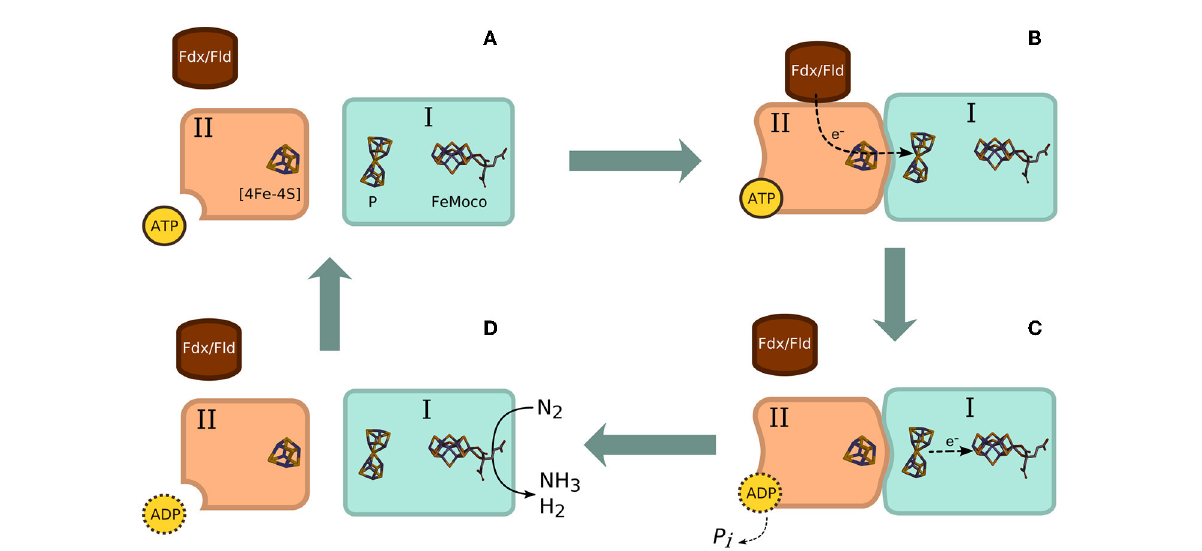
FIGURE4 Schematic presentation of nitrogen fixation via nitrogenase facilitation. (A) Detached nitrogenase components I ( dinitrogenase; MoFe protein ) and II ( dinitrogen reductase; Fe protein ) show II awaiting reduction by ATP. (B) ATP binds to component II initiating electron transfer from donor [Fdx ( ferredoxin ) or Fld ( flavodoxin )]. ATP binding triggers an allosteric structural change which leads to the components attaching. A flow of electrons occurs from the [4Fe-4S] cluster on II to the P cluster on I. (C) Electrons are further shuttled to the